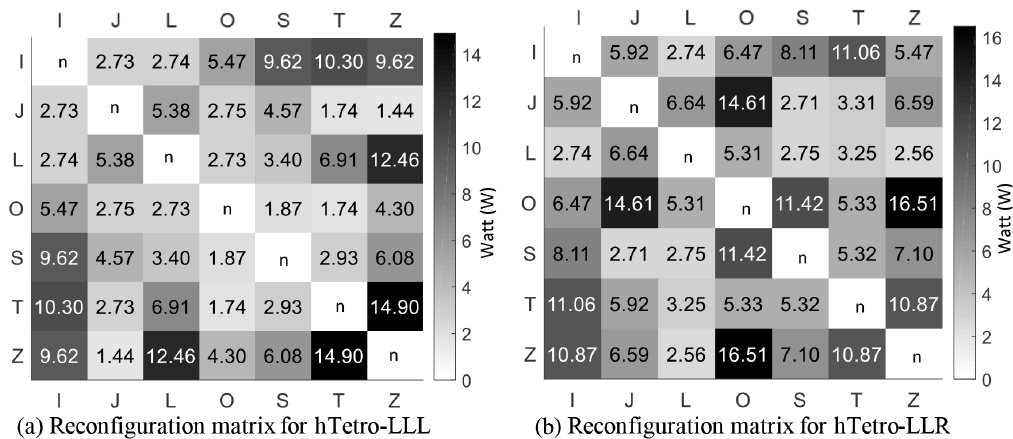
Figure 9. Power consumption during reconfiguration in simulation from one finite state to another in hTetro-LLL and